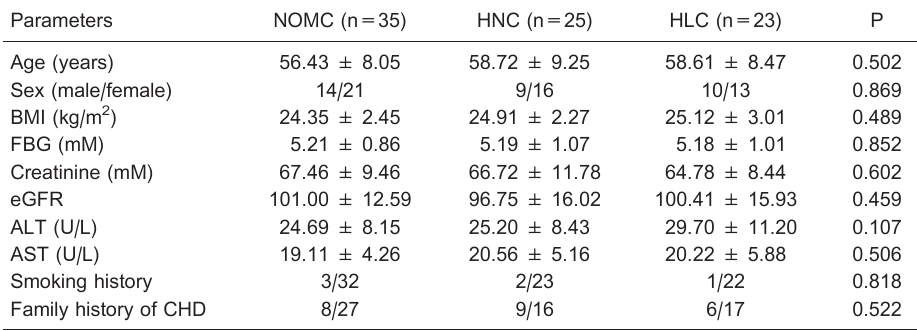
Table 1. Clinical and biochemical characteristics of HNC and HLC patients and NOMC volunteers. Parameters